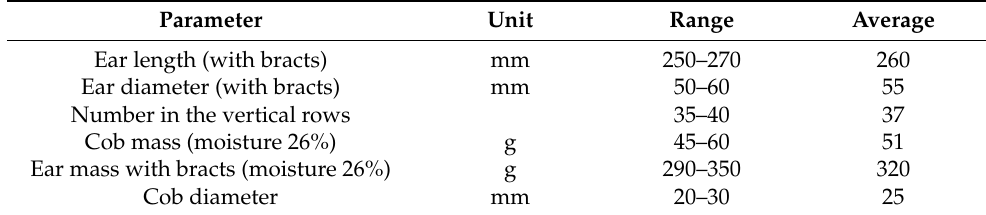
Table 1. Biological characteristics of Qiaoyu